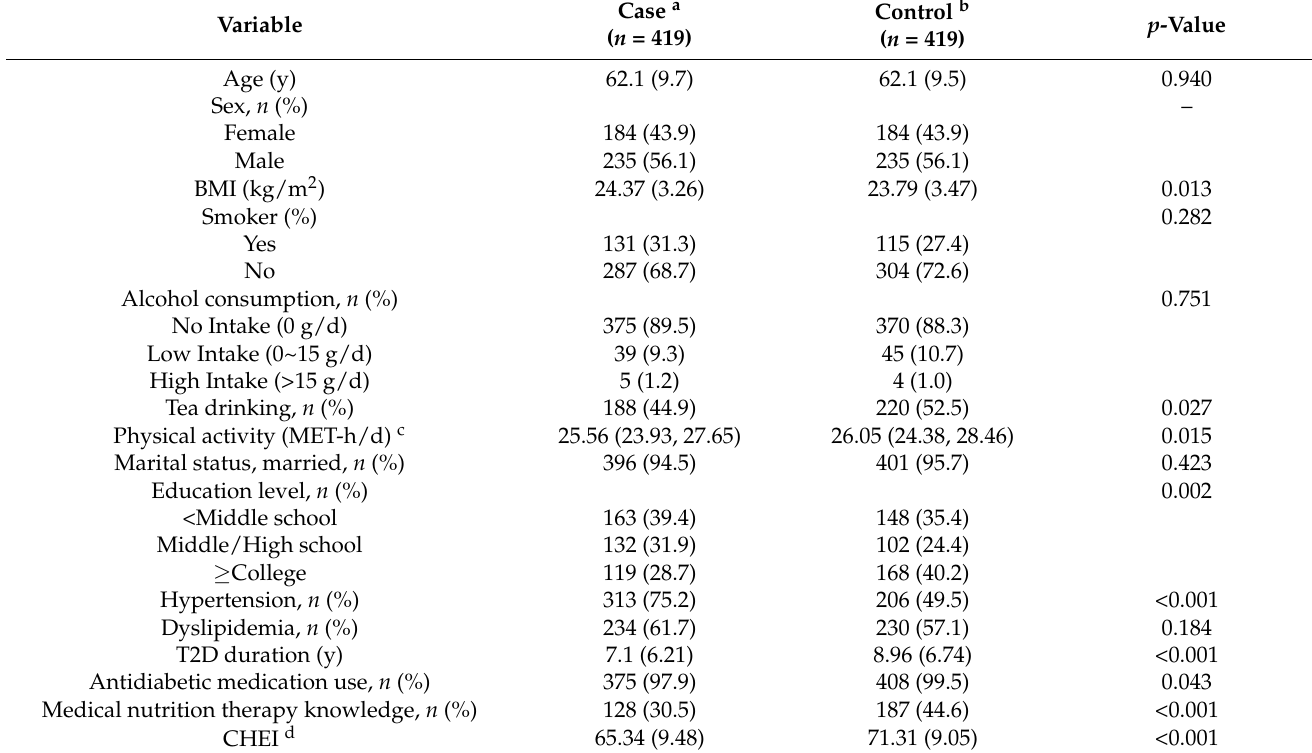
Table 1. Characteristics of the study